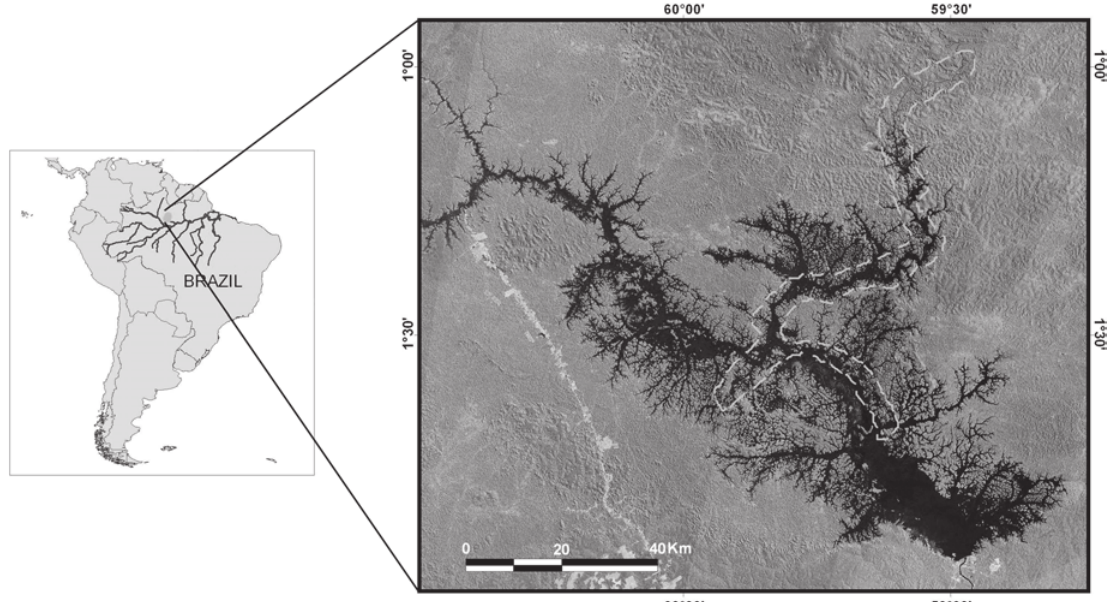
Figure 1. Map of the study area, Balbina reservoir (01º55’S, 59º29’W), municipality of Presidente Figueiredo, Amazon, Brazil. The area surveyed is delimited by the dotted